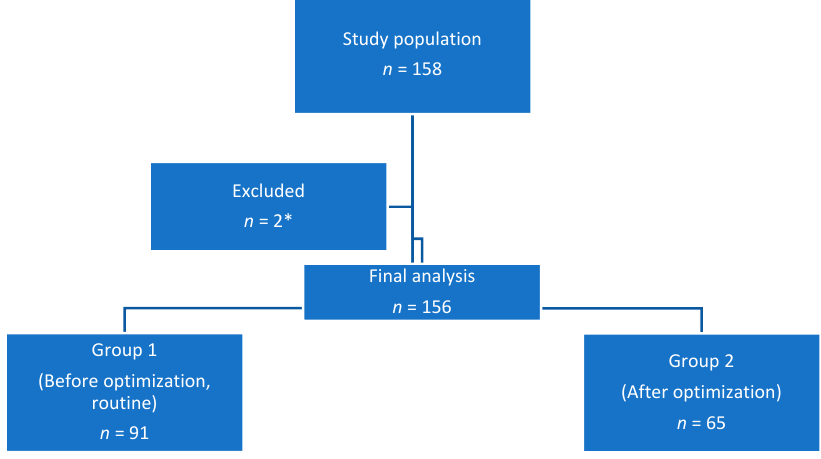
Figure 1. Study flowchart. * Exclusions concerned 2 patients who were below 18 years old at the time Figure 1. Study fl owchart . * Exclusions concerned 2 patients who were below 18 years old at the time of the study. of the